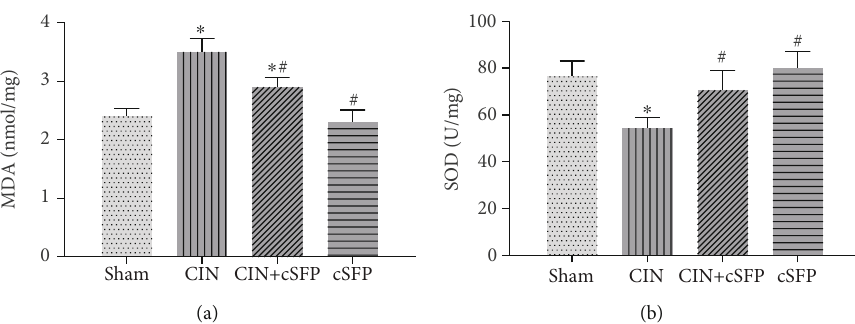
Figure 7: cSFP pretreatment reduced the renal oxidative stress in kidney tissues of CIN rats: (a) renal MDA concentration; (b) renal SOD activity. ∗ P < 0 : 05 versus sham rats; # P < 0 : 05 versus CIN